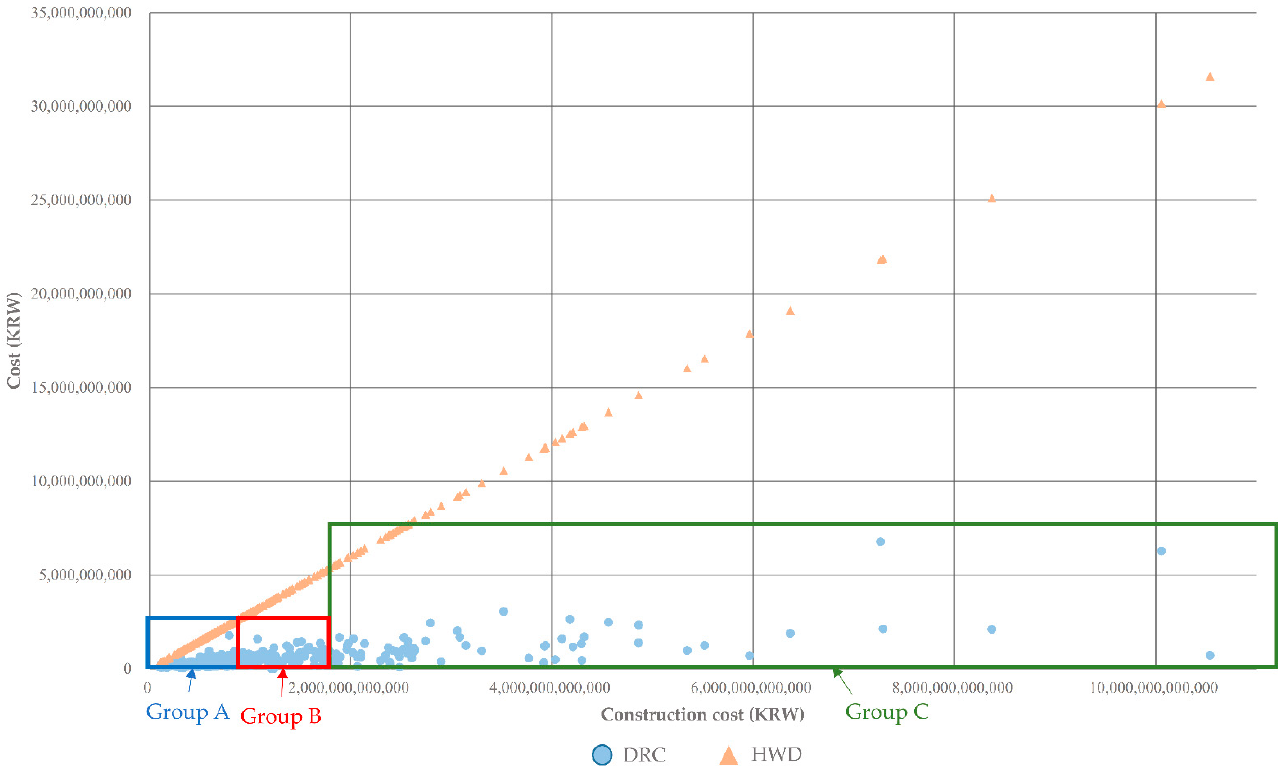
Figure 3. Distribution of DRC and HWD to CC scale.